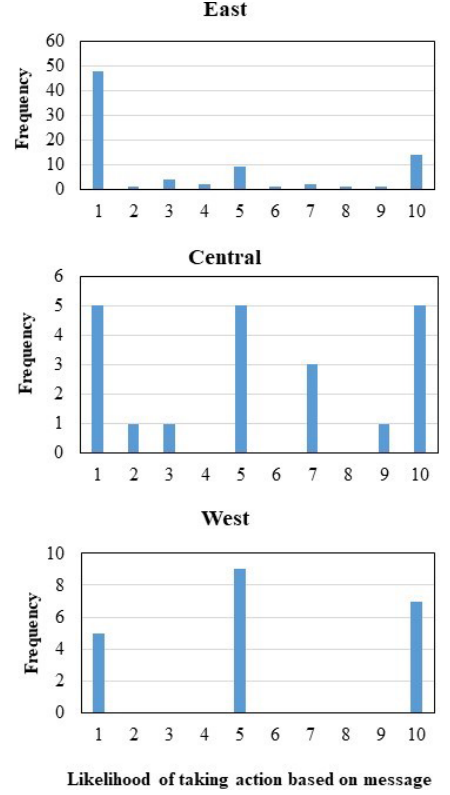
Figure 12. Likelihood of taking action based on warning message on a scale of 1–10, divided by district; responses closer to 10 indi- cate greater likelihood of